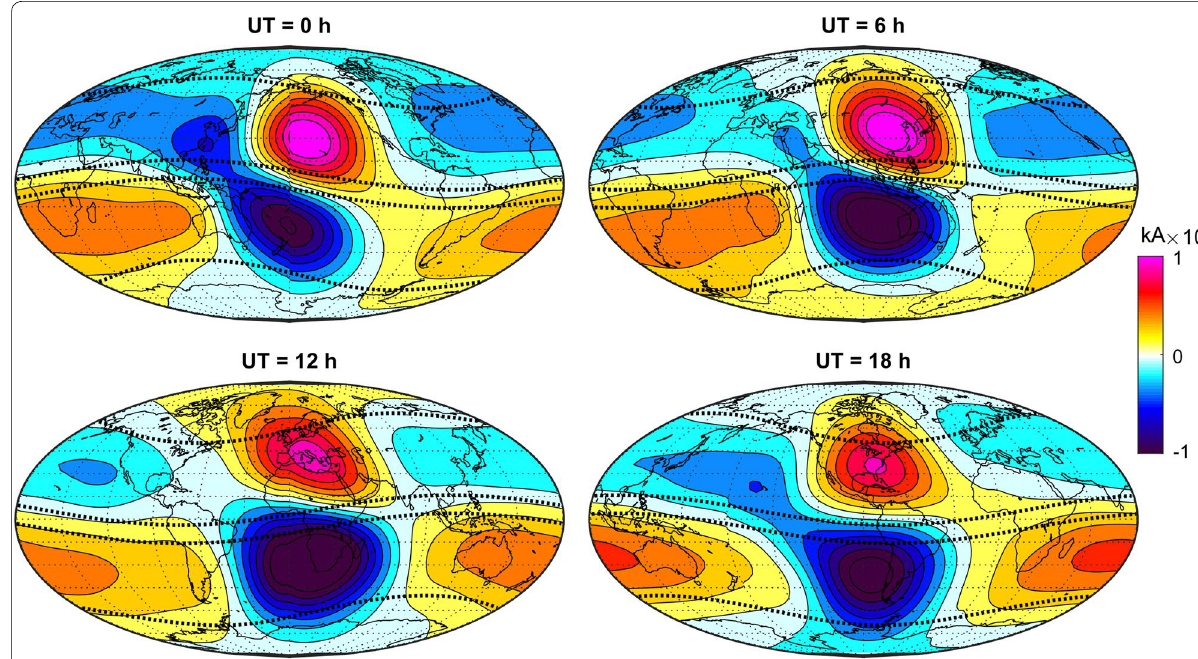
Fig. 2 Four snapshots of the Sq current system (in a form of stream function; in kA) estimated for a quasi-equinoctial day (March 16, 2011). Currents of the northern vortex move counterclockwise, and those of the southern vortex move clockwise. Dashed black lines show geomagnetic latitude ranges (between ± 6 ◦ and ± 60 ◦ ). All observatories used for Sq source estimation lie within these